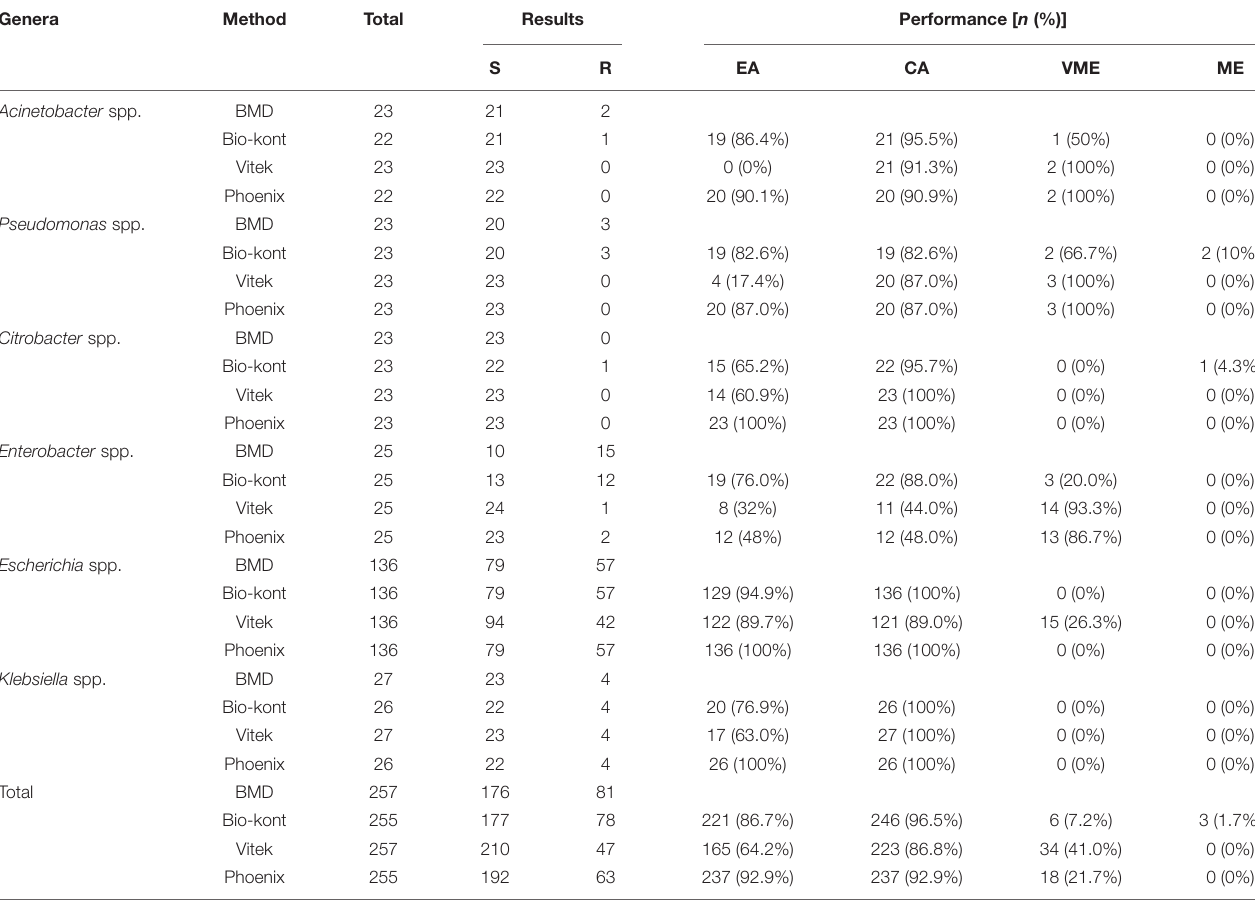
TABLE 2 | Comparison of performance characteristics to colistin between each of the three AST systems and BMD method for the seven genera in the 257 strains. Genera Method Total Results